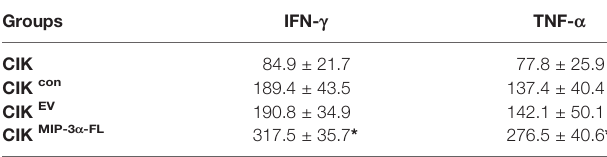
TABLE 3 | Comparison of cytokine secretion by CIK cells (pg/ml).